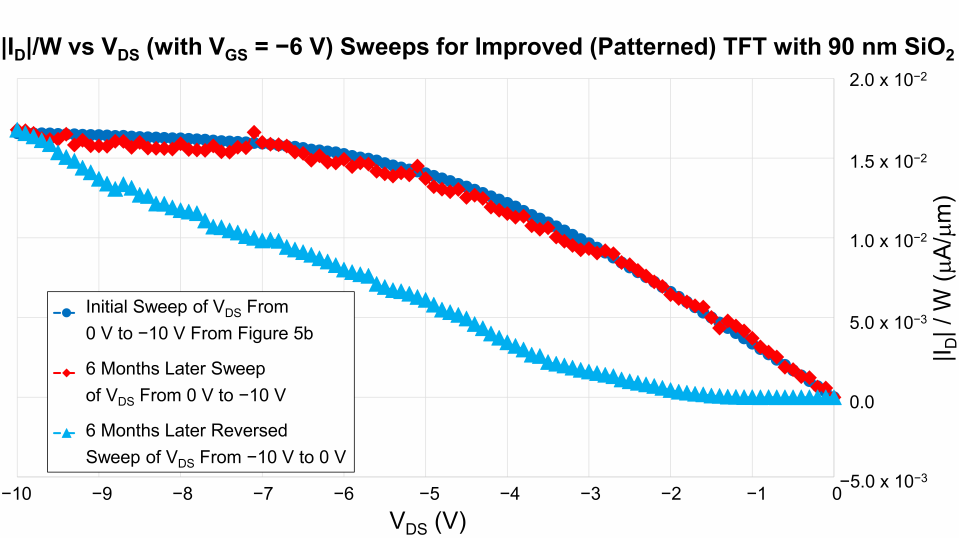
Figure 6. The |I D |/W versus V DS transfer characteristics for the improved (patterned) TFT with a 90 nm thick SiO 2 as V GS was held at − 6 V and V DS was: swept from 0 V to − 10 V as shown in Figure 5b (DARK BLUE), swept from 0 V to − 10 V again (RED), and swept in reverse from − 10 V to 0 V (LIGHT BLUE). The RED and LIGHT BLUE data was acquired six-months after the DARK BLUE data was